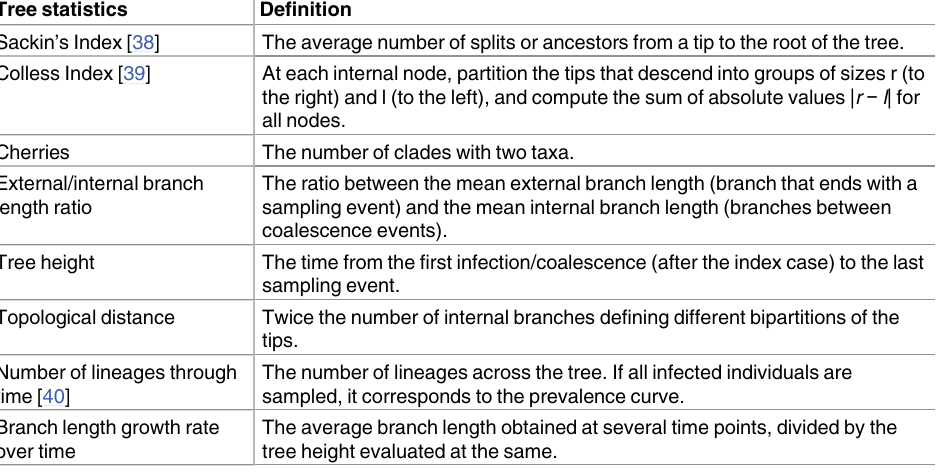
Table 1. Summary statistics computed on time scaled trees (transmission trees and virus